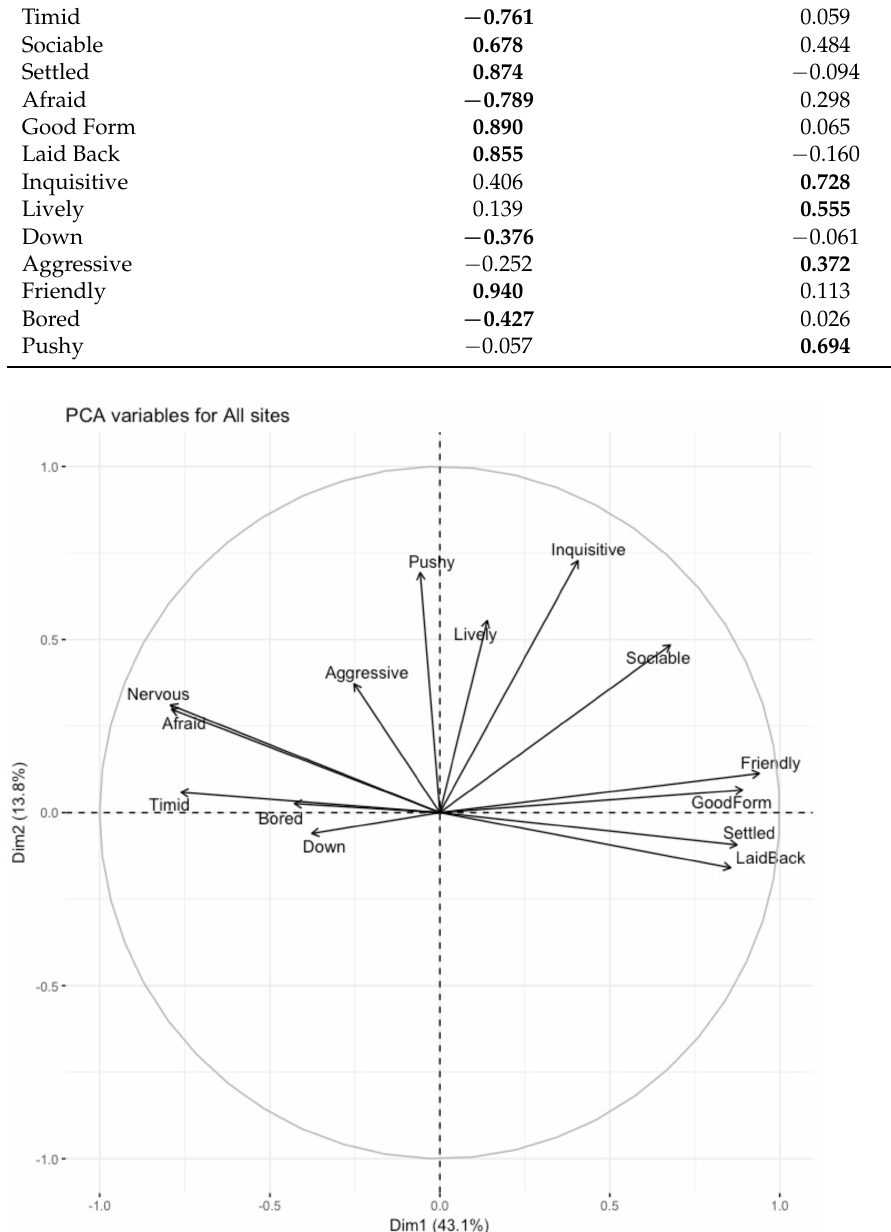
Figure 4. Bi-plot of descriptor loadings on Dimension 1 (mood) and Dimension 2